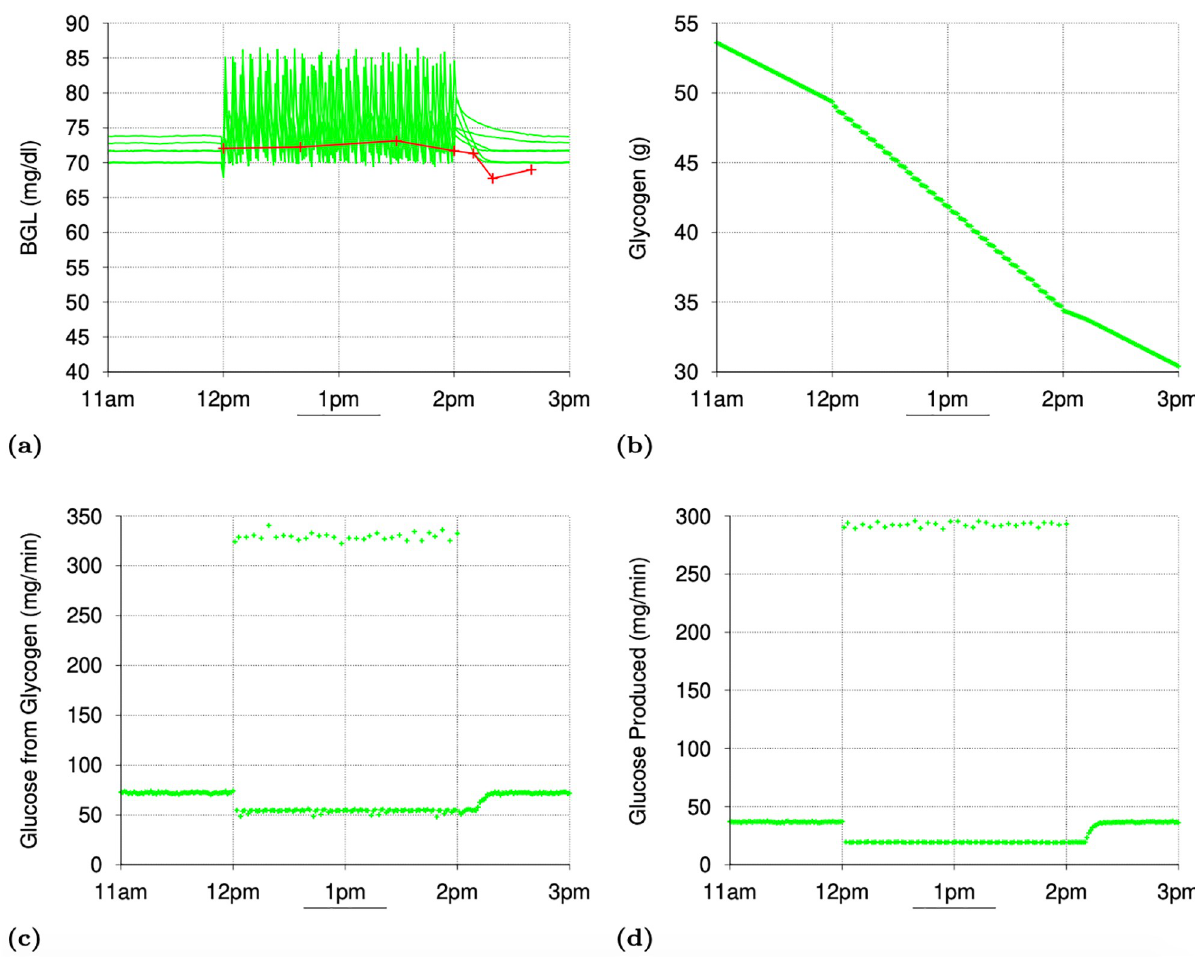
Fig 4. Results of simulations replicating a physical exercise event involving arms at intensity 30% VO 2 max as reported in [80]. (a): Green: BGL for 6 simulated subjects; Red: average BGL reported in [80]. (b): Liver glycogen for the subject # 1. (c): Liver glycogen breakdown for the subject # 1. (d): Total gluconeogenesis in Liver and Kidneys for the subject #